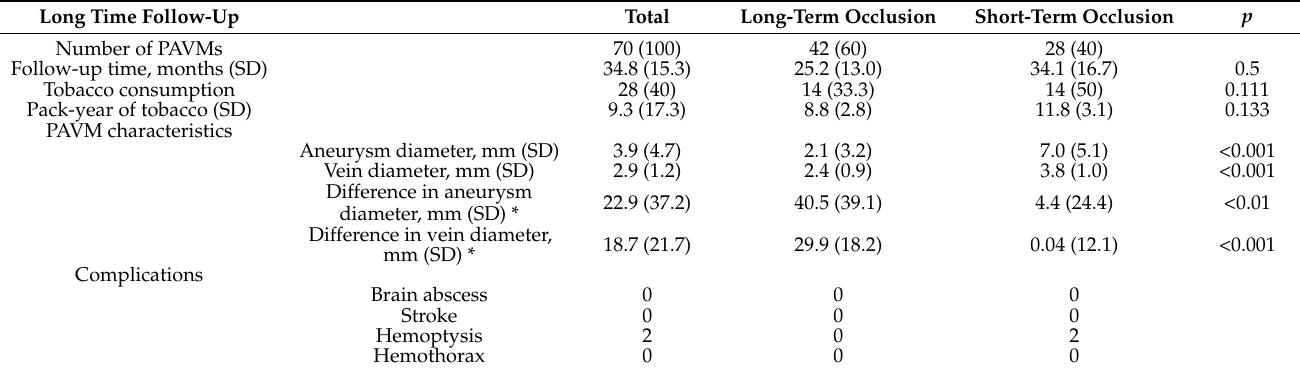
Table 4. PAVM follow-up data in the overall population and in the two groups, short- or long- term